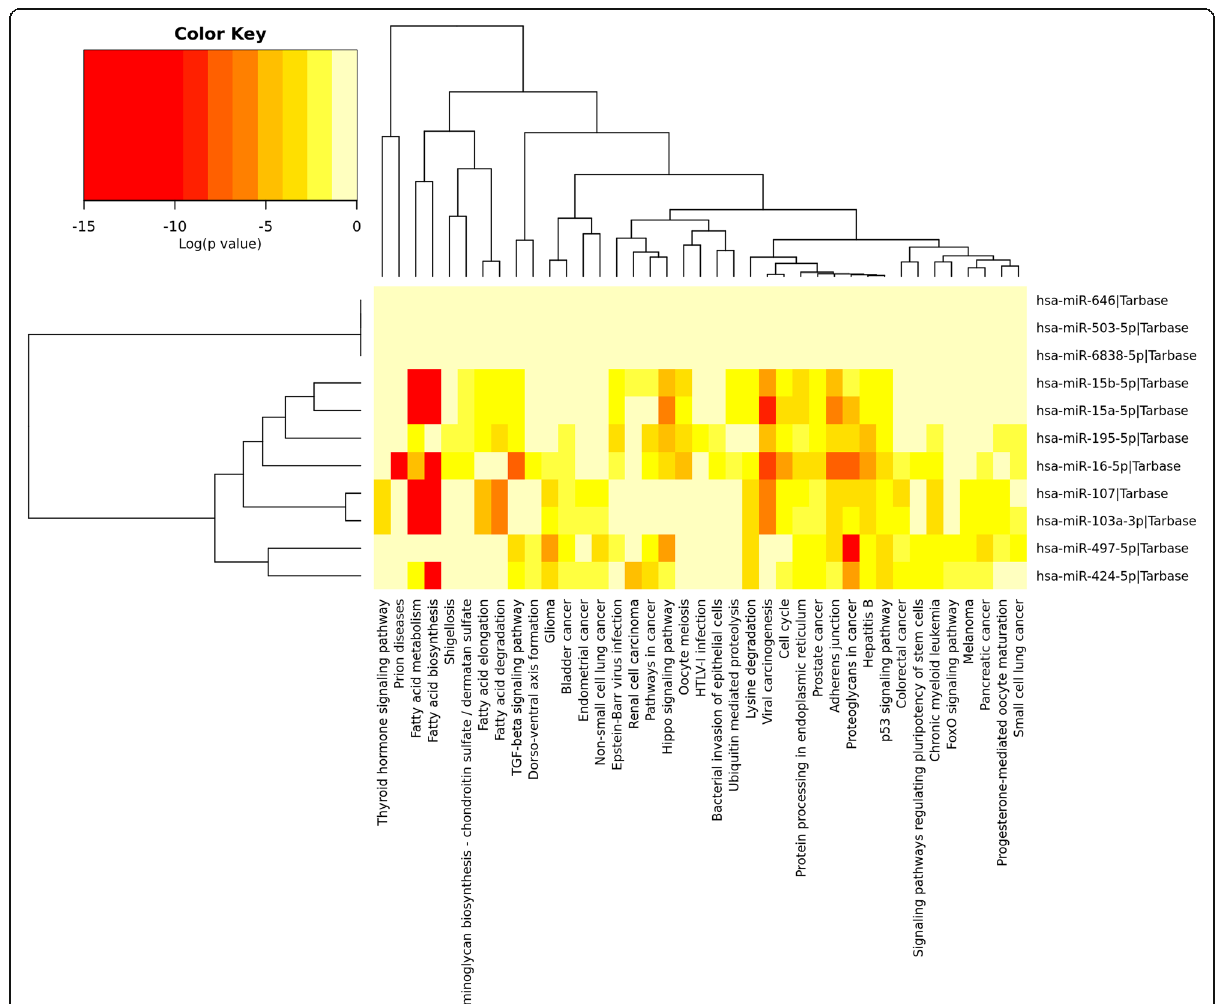
Fig. 4 Cluster dendrogram of miR-15/107 significantly regulated KEGG pathways calculated by miRPath v3.0